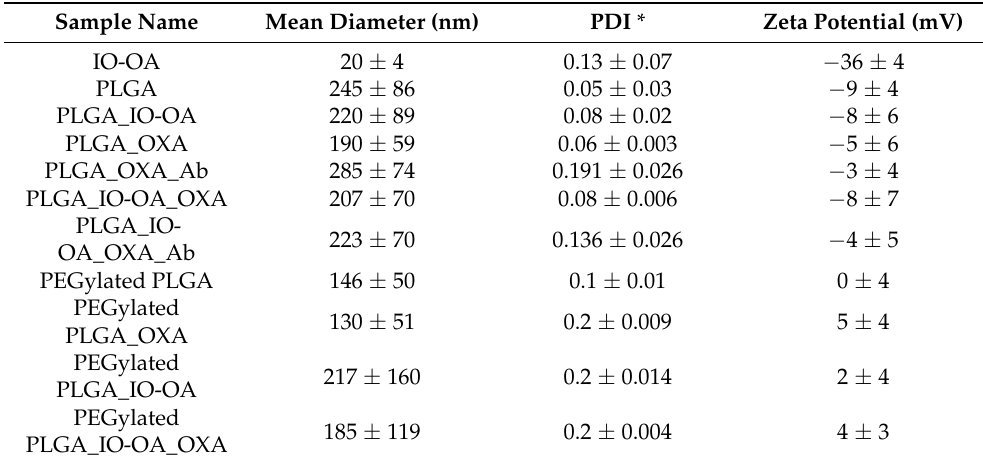
Table 1. Average diameter and zeta potential of the prepared nanoparticles.